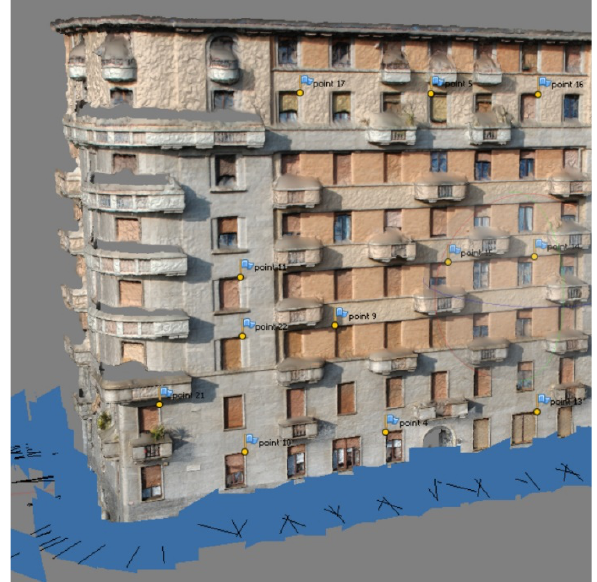
Figure 9 – Print-screen displaying the result of photogrammetric processing of RGB images in Case Study 2: the TIN model of the building façade textured with RGB photos, the location of extracted GCP’s for co-registration of IR images, and estimated camera